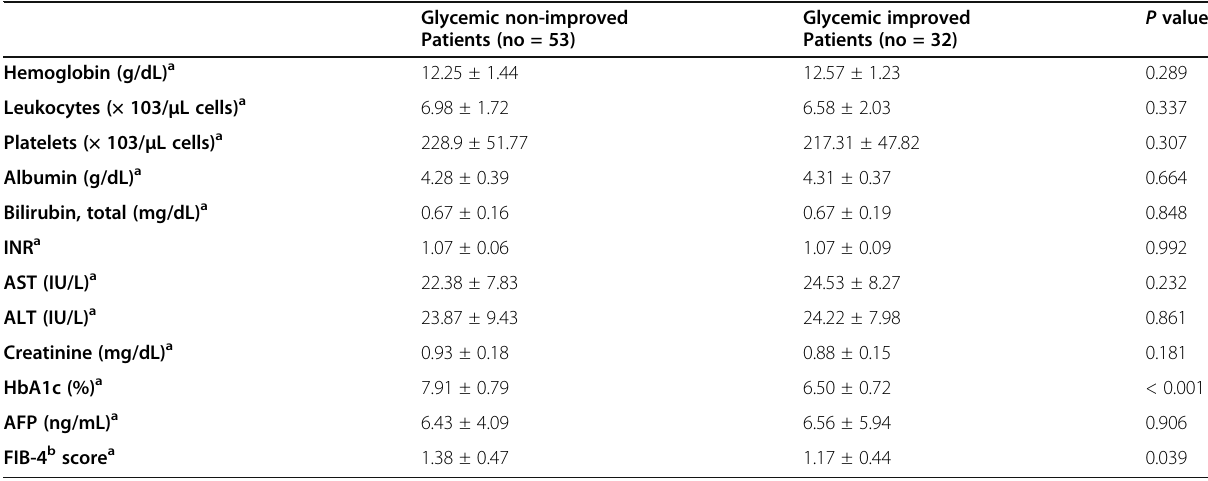
Table 2 Statistical comparison of the post-treatment parameters in glycemic improved patients versus glycemic non-improved patients